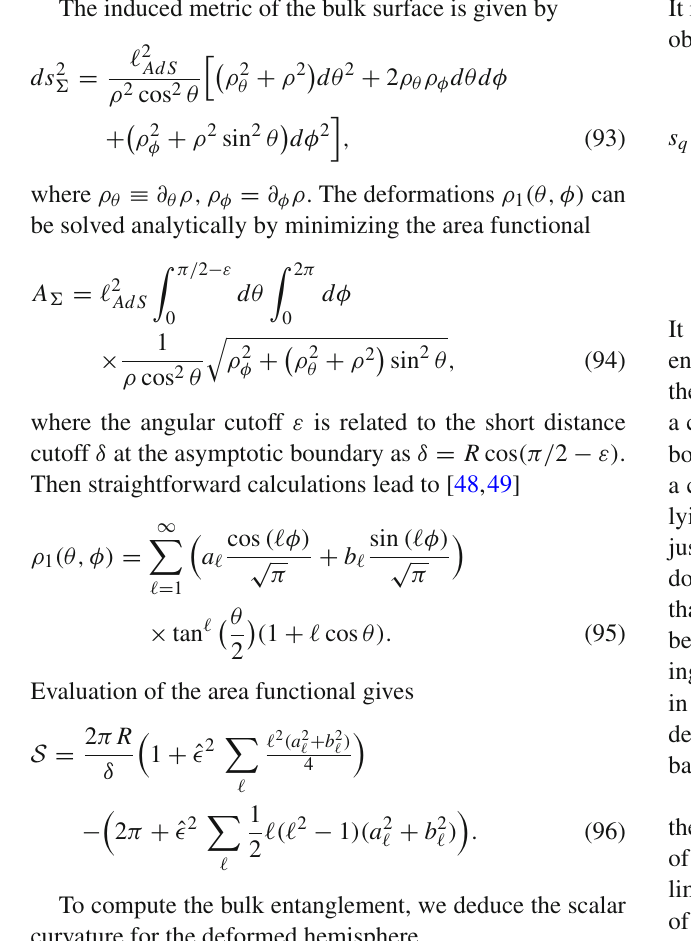
dashed red) whilst in the smooth limit (cid:16) → π , a ((cid:16)) = (π − (cid:16)) 2 / 2 π and b ((cid:16)) = 3 (π − (cid:16)) 2 / 80 π 2 (show in dashed green). In both limits, (cid:5) (cid:6) b ((cid:16))/ a ((cid:16)) = 3 / 40 ) 4 / 20 π 2 (cid:16) (shown in 4